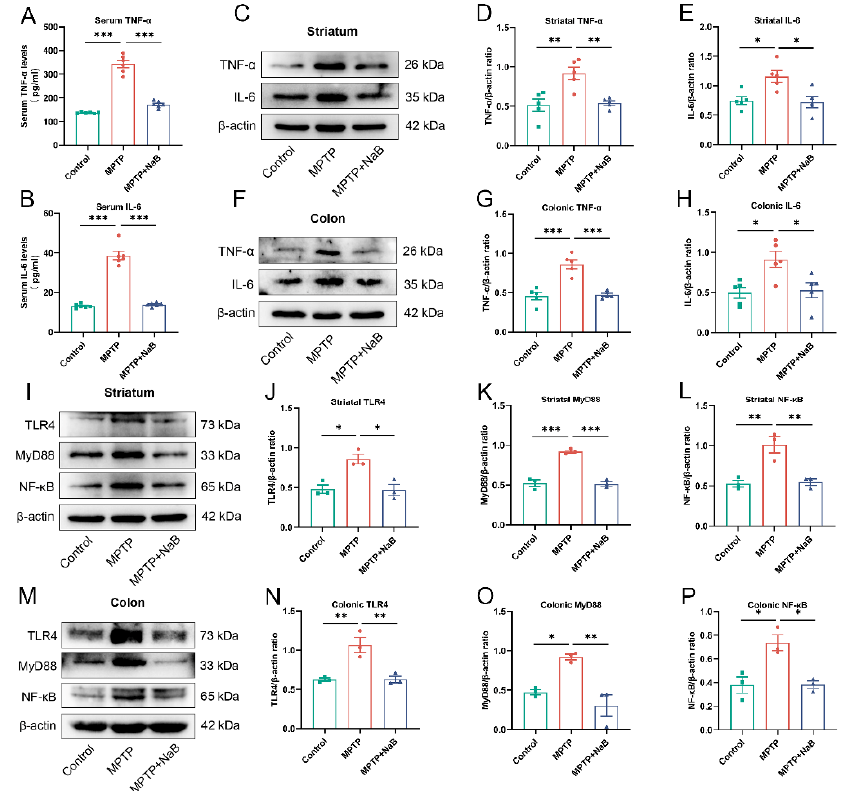
Figure 7. Neuroinflammation and intestinal inflammation were attenuated following Sodium bu- tyrate (NaB) treatment due to the inhibition of the TLR4/MyD88/NF-B signaling pathway. ( A , B ) The levels of serum inflammatory cytokines, TNF- α , and IL-6. ( C , F ) Representative Western blots for striatal and colonic IL-6 and TNF- α expression. ( D , E , G , H ) Band intensities of TNF- α and IL-6 in the striatum and colon were quantified using ImageJ and normalized to β -actin. ( I , M ) TLR4, MyD88, and NF-B expression levels in the striatum and colon are shown in a representative Western